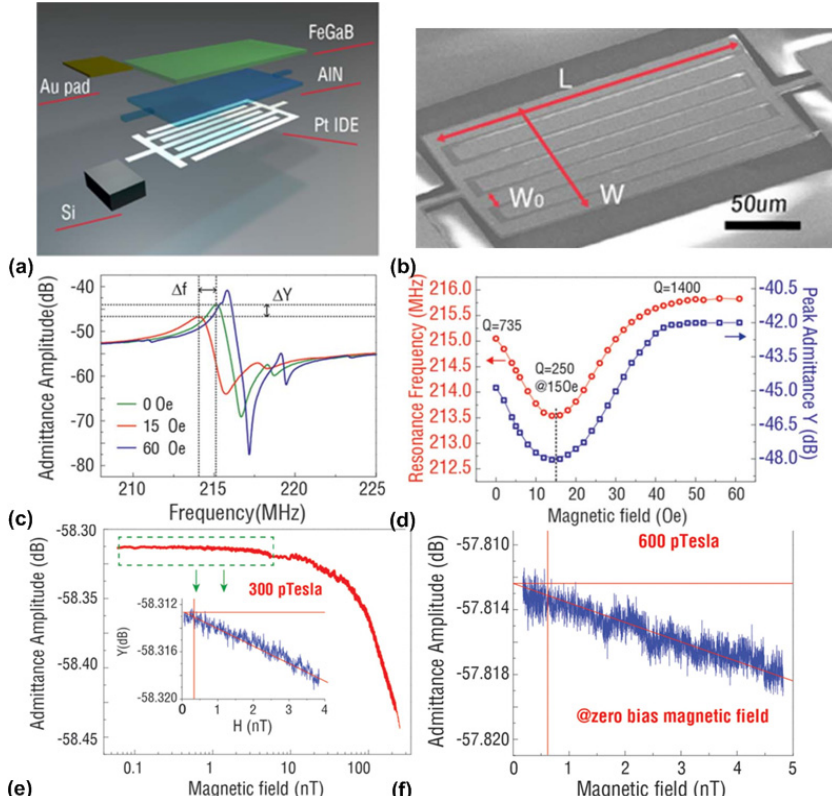
Figure 7. ( a ) Schematic of the layered structure for the nanoplate magnetometer; ( b ) SEM of the fabricated magnetometer; ( c ) measured admittance frequency spectrum of the magnetometer; ( d ) Measured resonant frequency and admittance of the magnetometer; ( e ) measured admittance showing the sensitivity and linearity of magnetometer under DC bias magnetic field of 5 Oe; and ( f ) measured admittance showing the sensitivity and linearity of magnetometer under zero bias magnetic field. This figure is reproduced from [61].